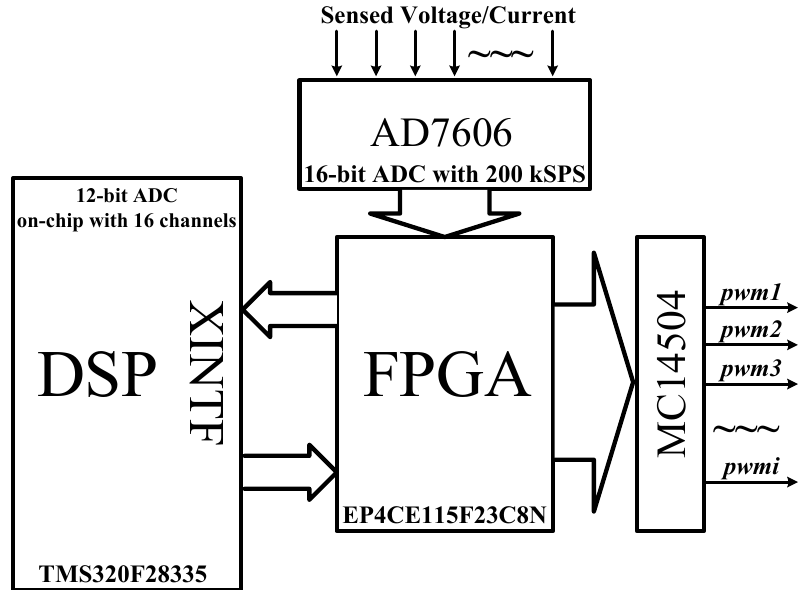
Figure 29. Experimental structure of the modified MMC.